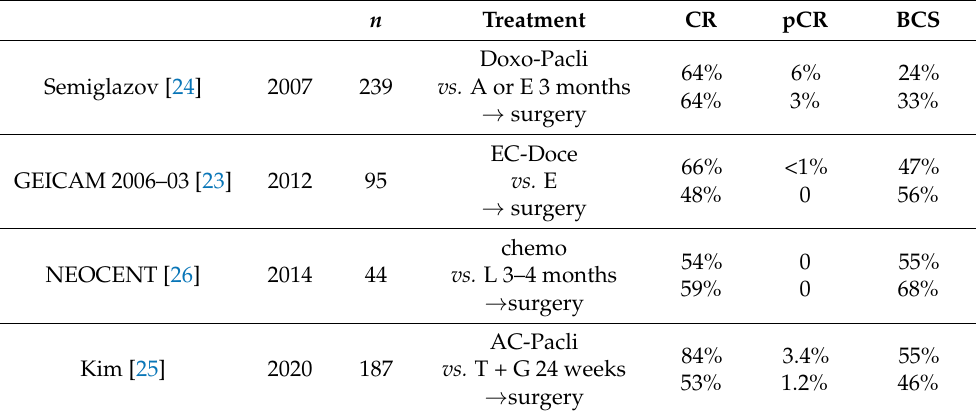
Table 2. Randomized trials comparing neoadjuvant chemotherapy (NCT) vs. neoadjuvant endocrine therapy